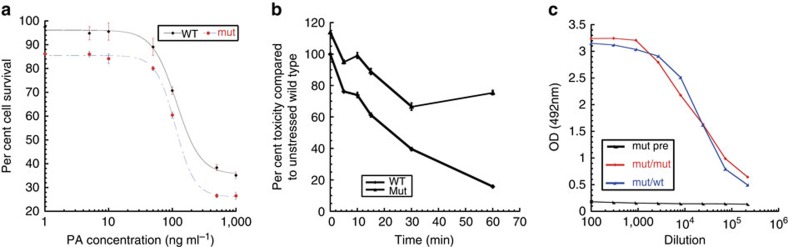
Comparison of the biological activity of WT and mutant PA.(a) Concentration dependence of the toxicity of PA in the presence of lethal factor to mouse macrophage Raw264.7 cells. (b) Per cent toxicity of PA in the presence of lethal factor to Raw264.7 cells after increasing times of heat stress at 45 °C to the protein sample before the assay. (c) Binding of antiserum raised against mutant PA to WT and mutant PA.